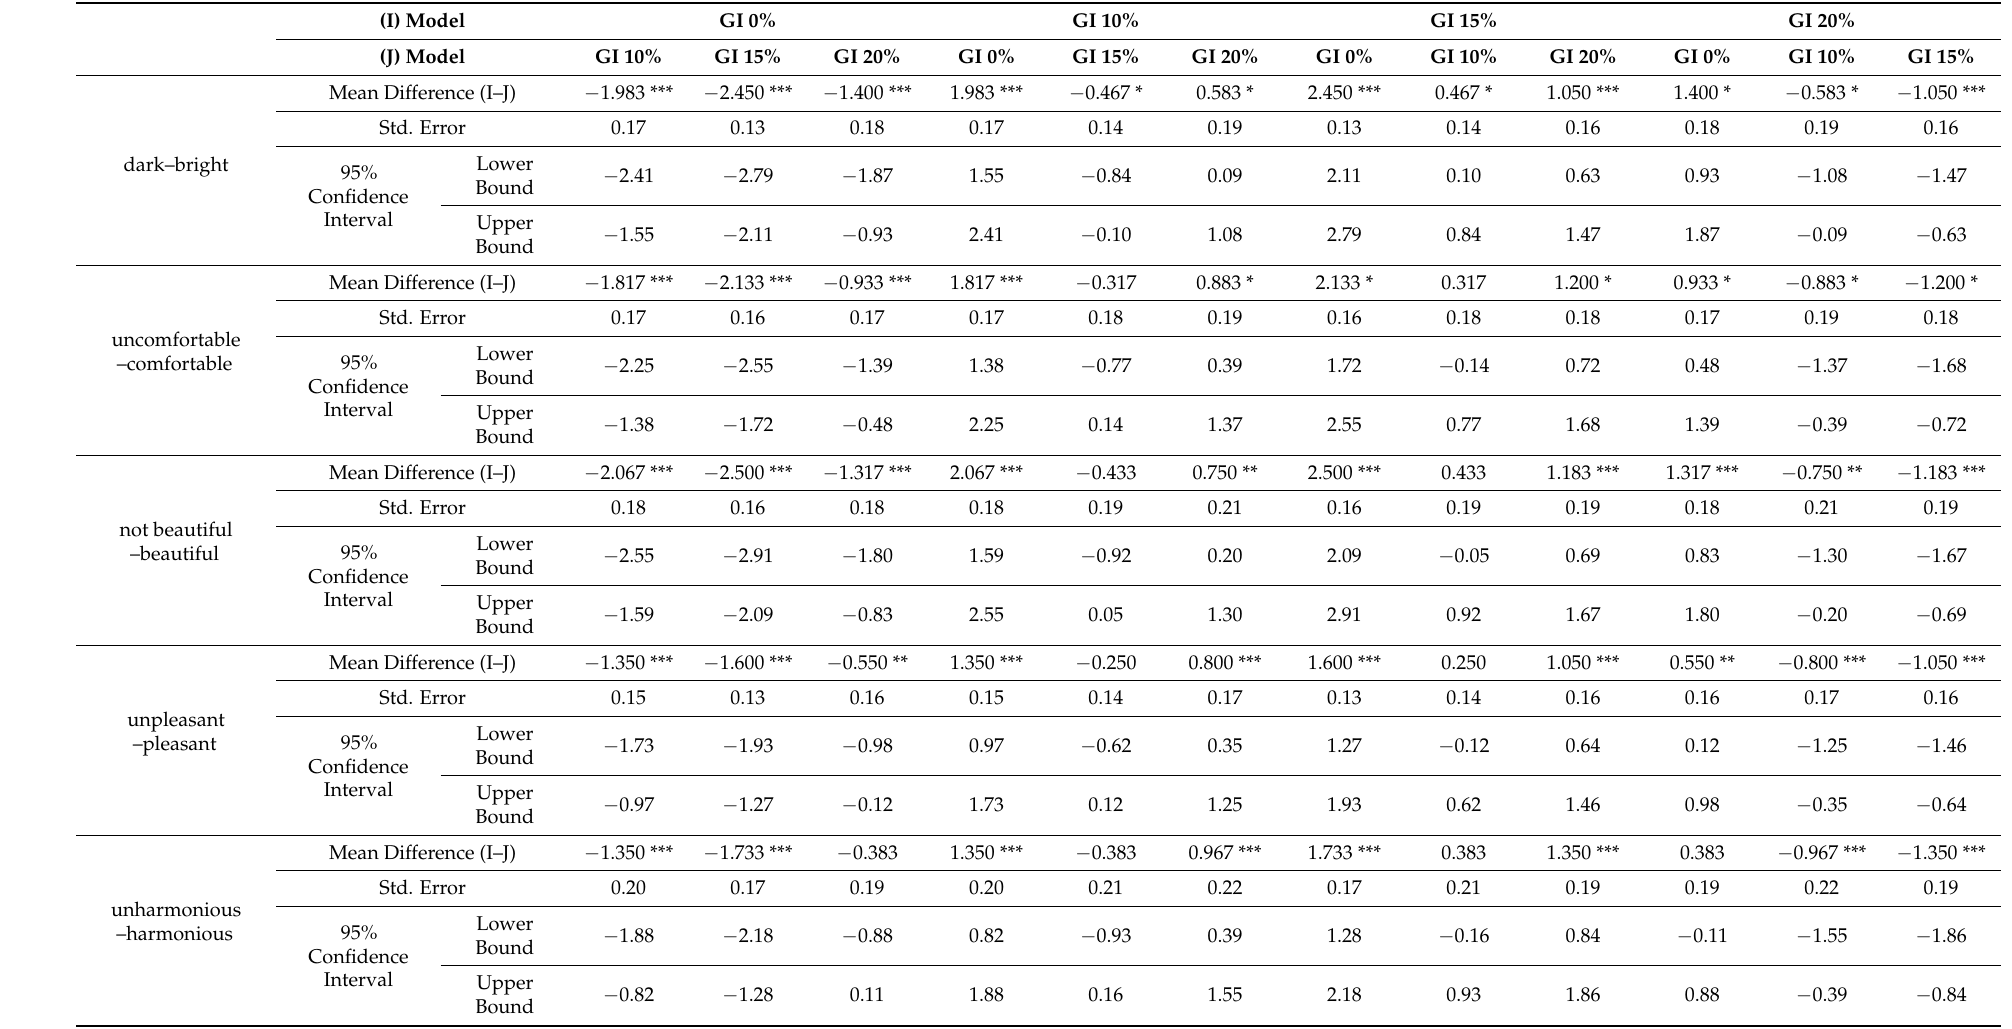
Table 12. Post-hoc Test Analysis for Interior Landscape Model Space Image in Underground